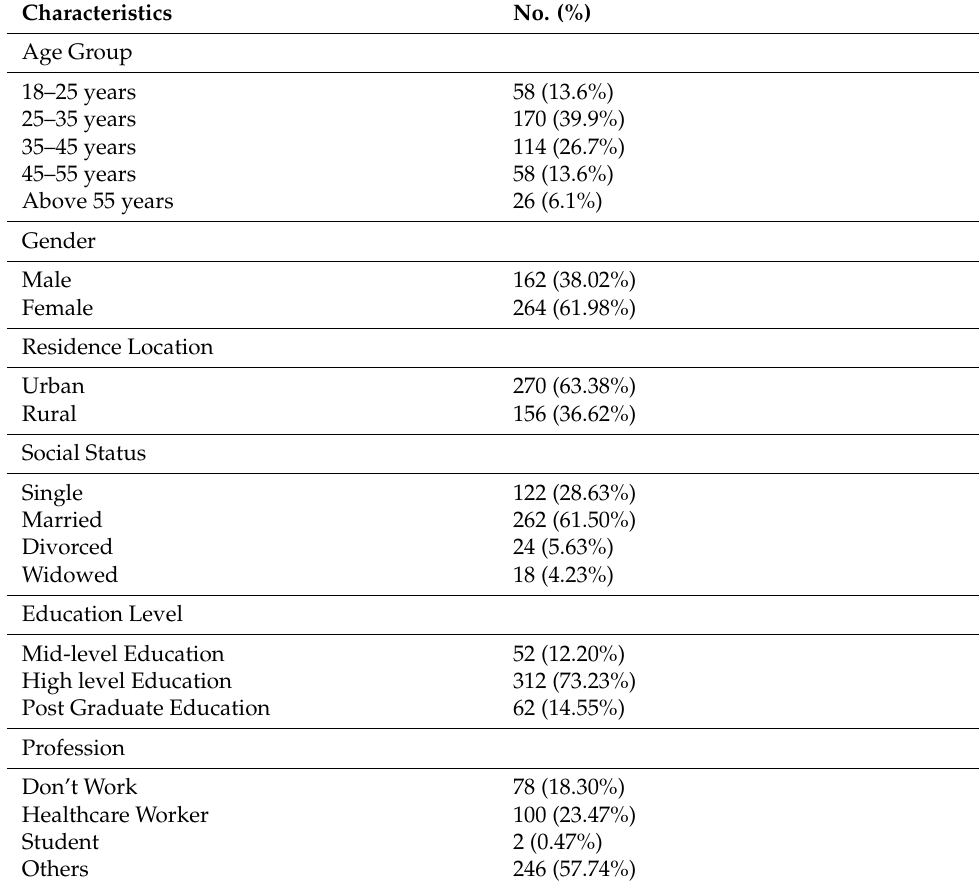
Table 1. Participants’